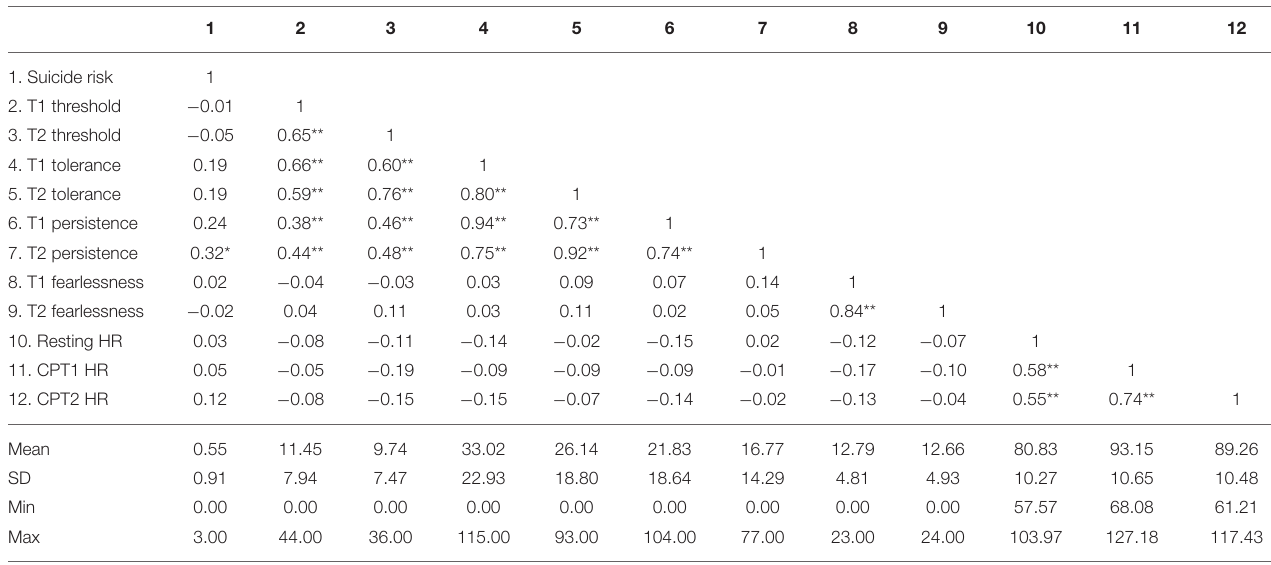
TABLE 3 | Study 2 correlations and descriptive